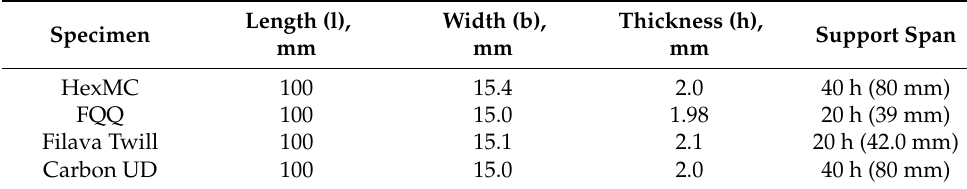
Figure 7. ( a ) flat HexMC specimens, ( b ) FQQ specimens .